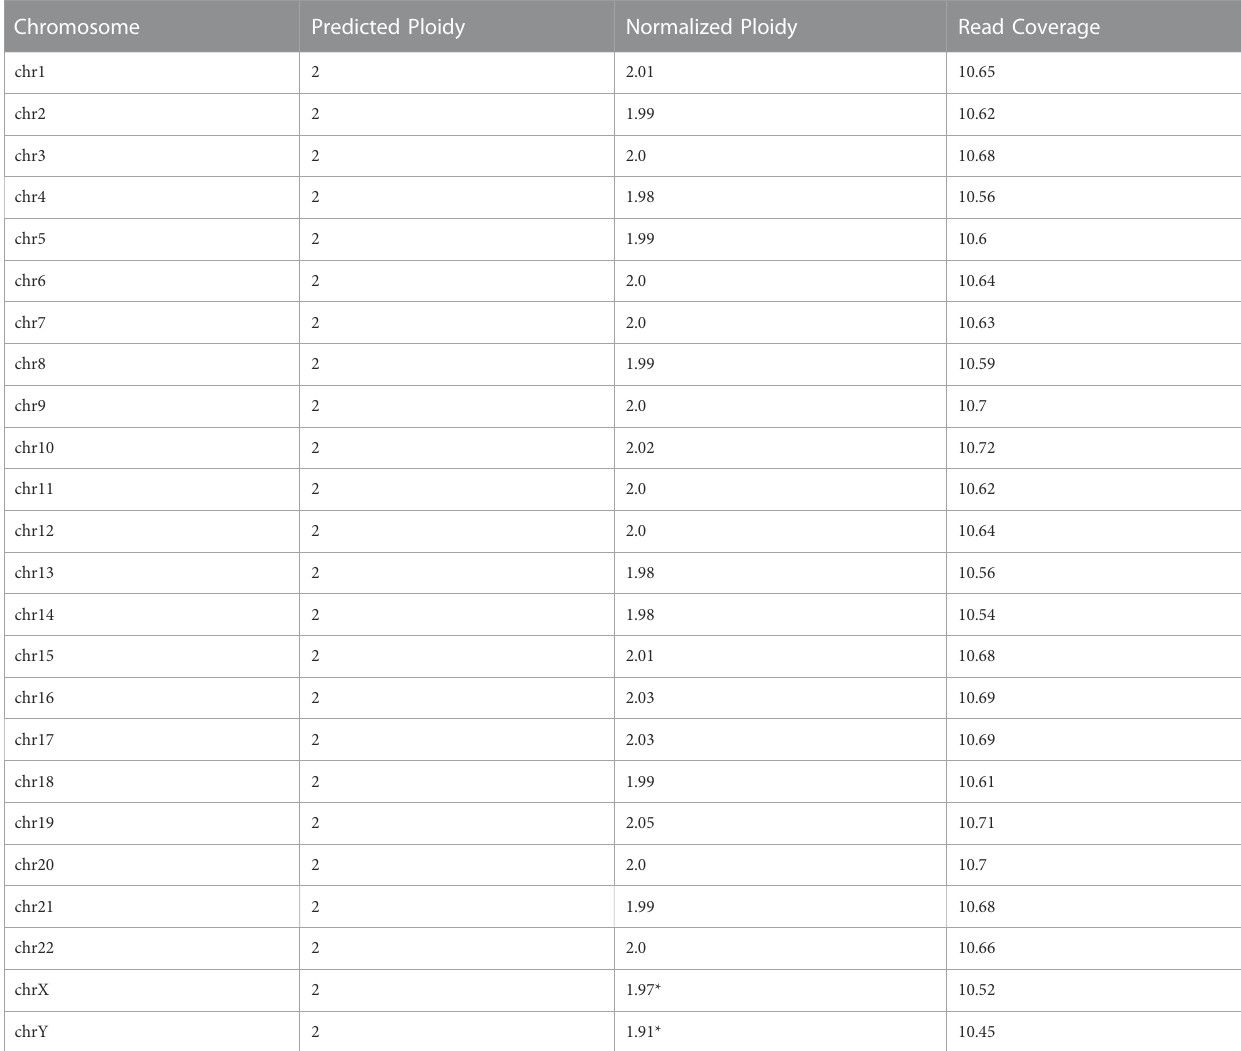
TABLE 6 Aneuploidy con fi rmation for 48, XXYY syndrome (Sample_10). Chromosome